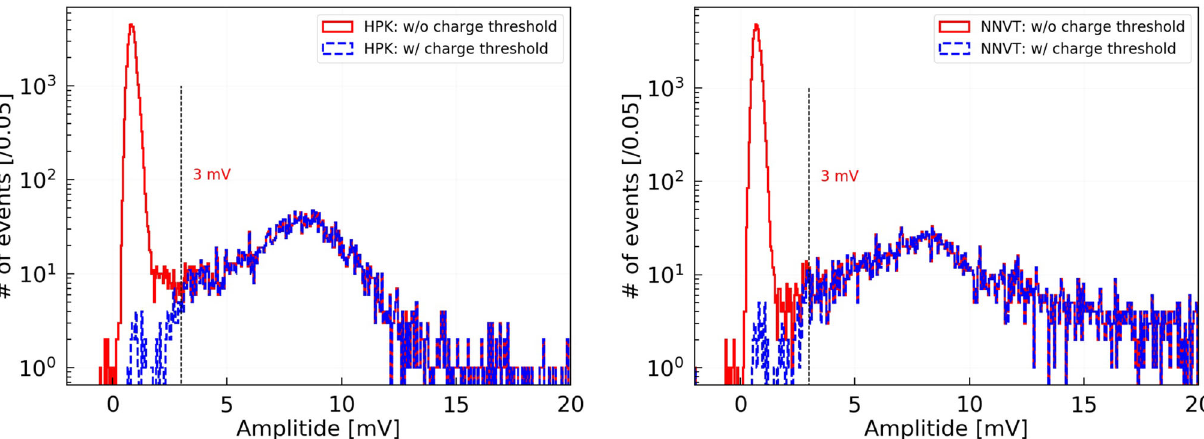
Fig. 20 Effect of the set amplitude threshold on the DCR measurement of a single, typical PMT. The cut distributions (in blue) represent all pulses with a charge above the threshold of 0.25 p.e., matching well to a pulse amplitude threshold of 3 mV. Left: HPK pulse amplitudes; right: NNVT pulse amplitudes